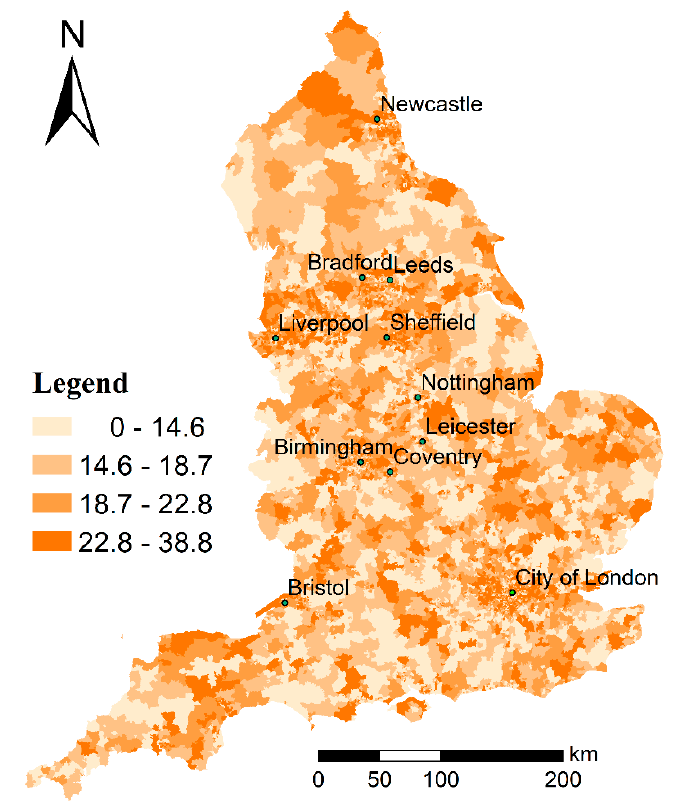
Figure 1. Middle Super Output Area (MSOA) ‐ level percentage of obese children in Year 6 (age 10–11 years) across England, 2013/14 to 2015/16.